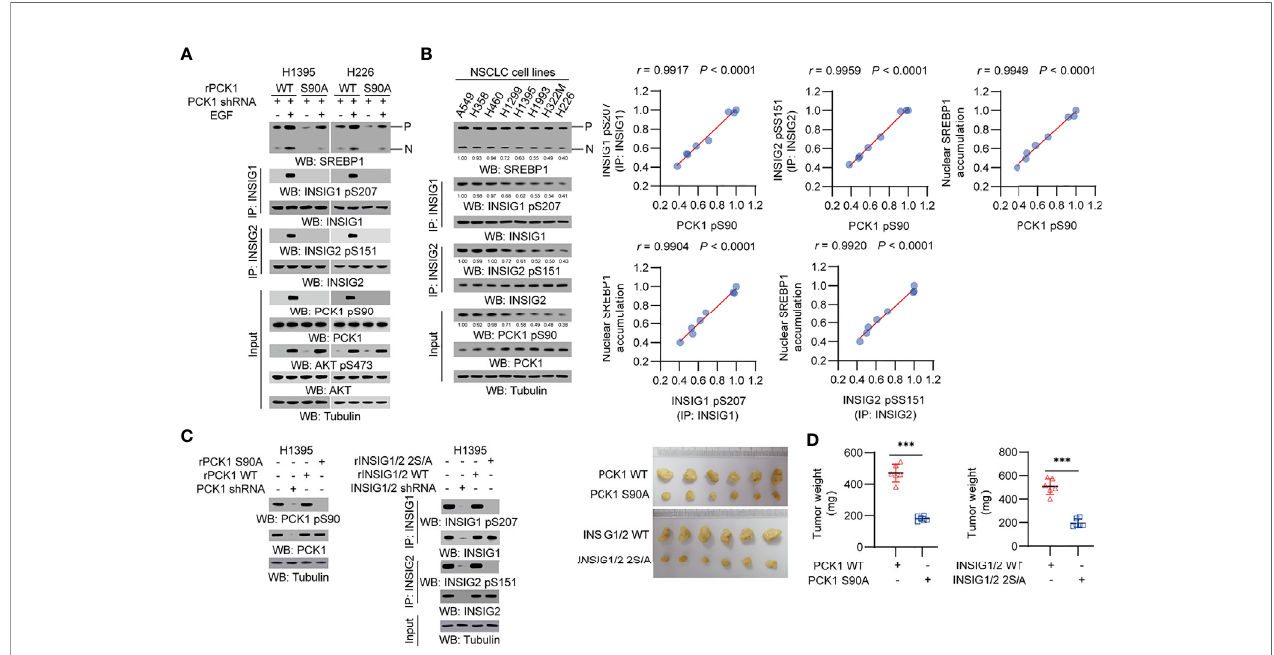
FIGURE 1 | PCK1 protein kinase activity-mediated activation of SREBP1 occurs in NSCLC cells and promotes tumor growth in mice. (A) H1395 and H226 cells were transfected with the indicated plasmids. Immunoprecipitation or immunoblotting analyses were performed with the indicated antibodies. (B) Immunoprecipitation or immunoblotting analyses were performed with the indicated antibodies in the indicated cells. Correlation analyses were performed. A Pearson correlation test was used (two-tailed) ( n = 8). (C, D) H1395 cells (1 × 10 6 ) with expression of rPCK1, rPCK1 (S90A), rINSIG1/INSIG2 or the rINSIG1 S207A/rINSIG2 S151A double mutants were subcutaneously injected into the left or right fl anks of athymic nude mice, respectively ( n = 6 per group). The resulting tumors were resected 28 days after injection (C) . The tumors in the mice were weighed (D) . Data are mean ± S.D. ( n = 6). *** P < 0.001 compared with the wild-type group (two-tailed t -test). Immunoblotting analyses were performed with the indicated